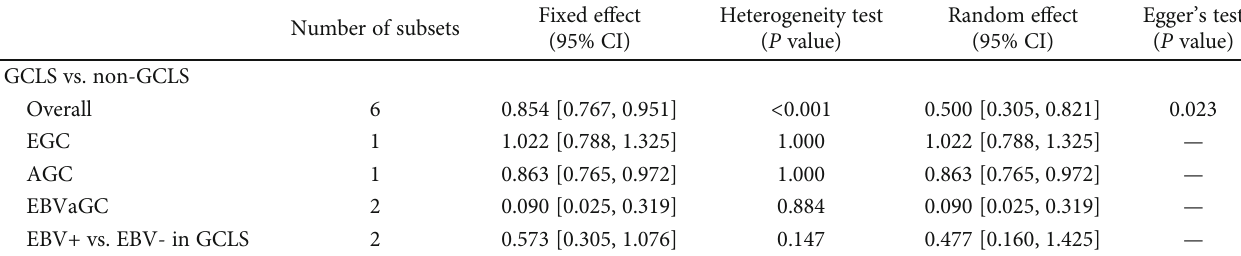
Table 5: The prognostic implications of gastric carcinoma with lymphoid